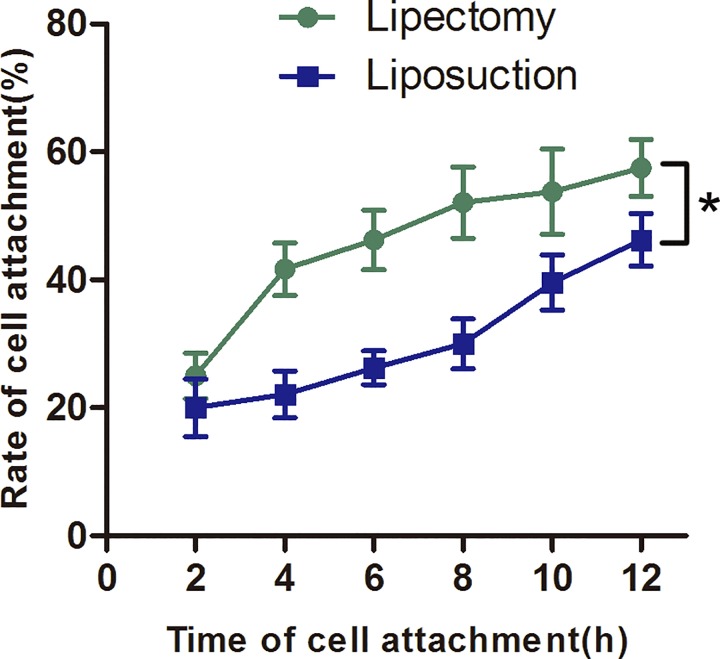
Cell attachment rate of ADSCs from lipectomy and liposuction (n = 3, * p<0.05).